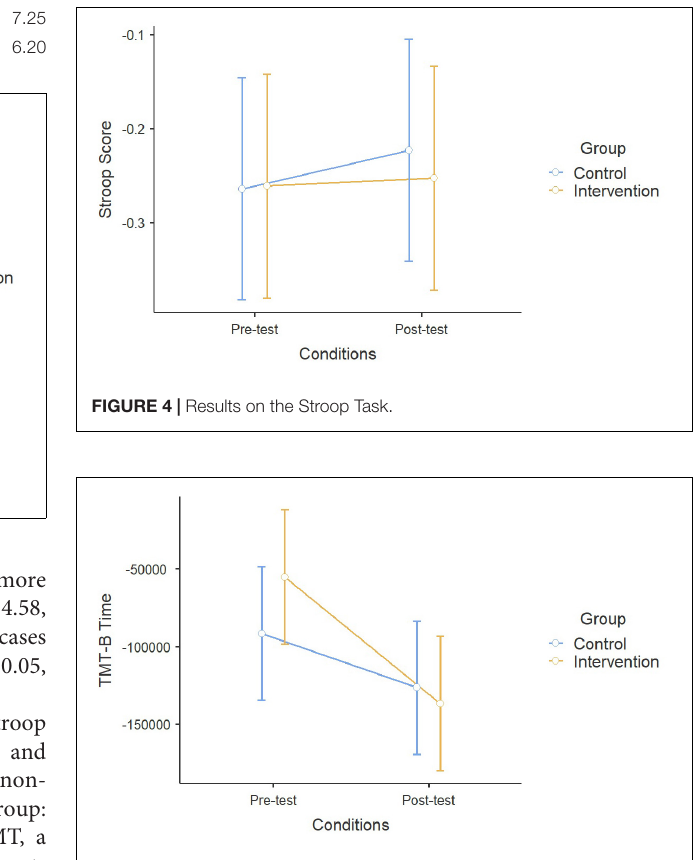
FIGURE 5 | Results on the Trail Making